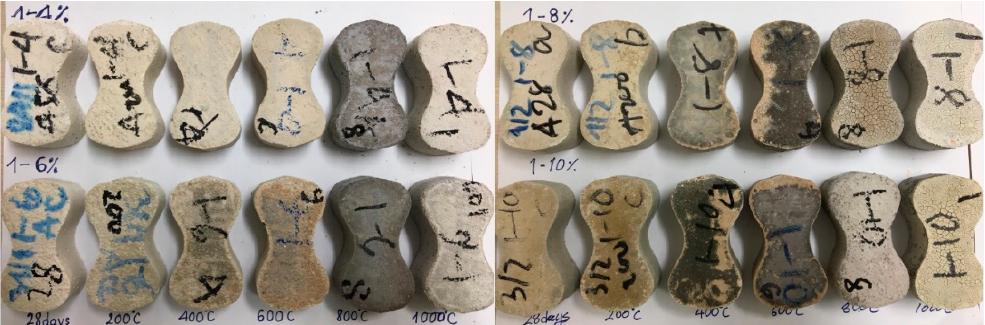
Figure 4. Photographs of AAS mortar samples activated with different concentration of Na 2 O before and after exposure to high temperatures from 200 to 1000 ° C .